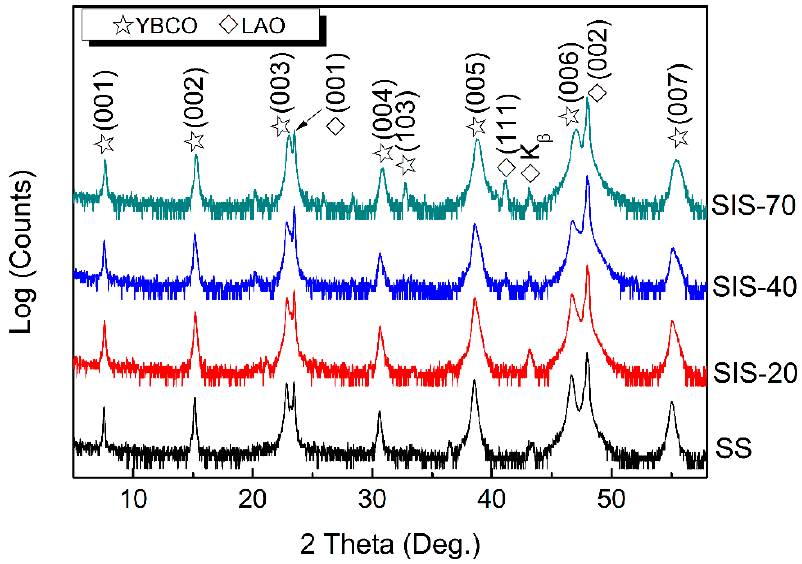
Figure 4. XRD patterns of YBCO/LAO/YBCO trilayer films.